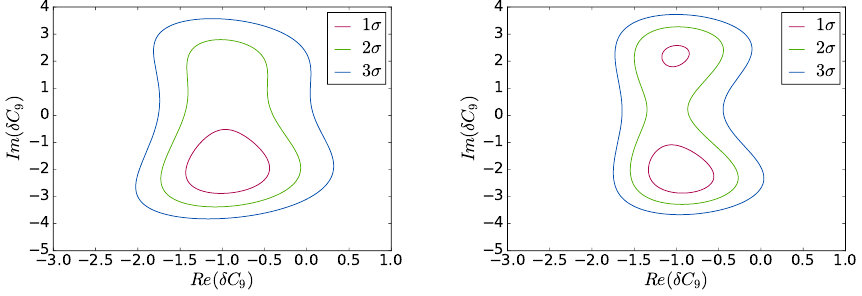
Figure 2 . Contour plots for real and imaginary parts of (cid:14)C 9 . The contours on the left correspond to (cid:12)ts up to q 2 = 6 GeV 2 , and the contours on the right correspond to (cid:12)ts up to q 2 = 8 GeV 2